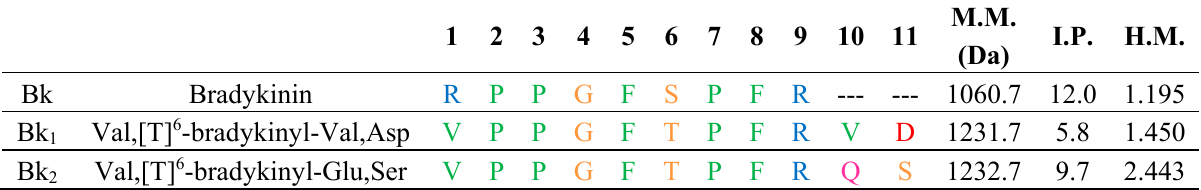
Table 1. Amino acid sequences of the bradykinin and